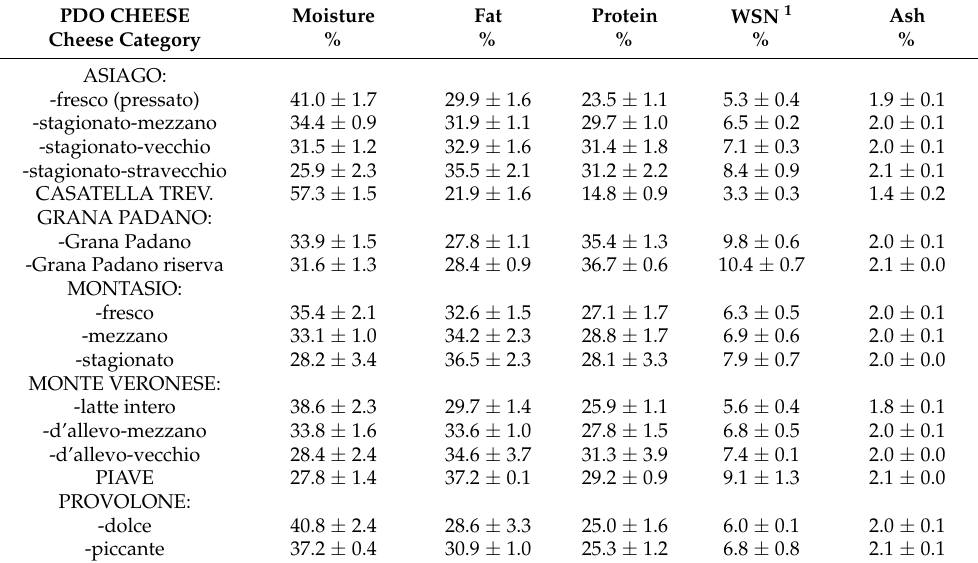
Table 5. Chemical compositions of the cheeses with EU Protected Designation of Origin (PDO) status (averages and standard deviations by cheese category, expressed as % by mass). PDO CHEESE Cheese